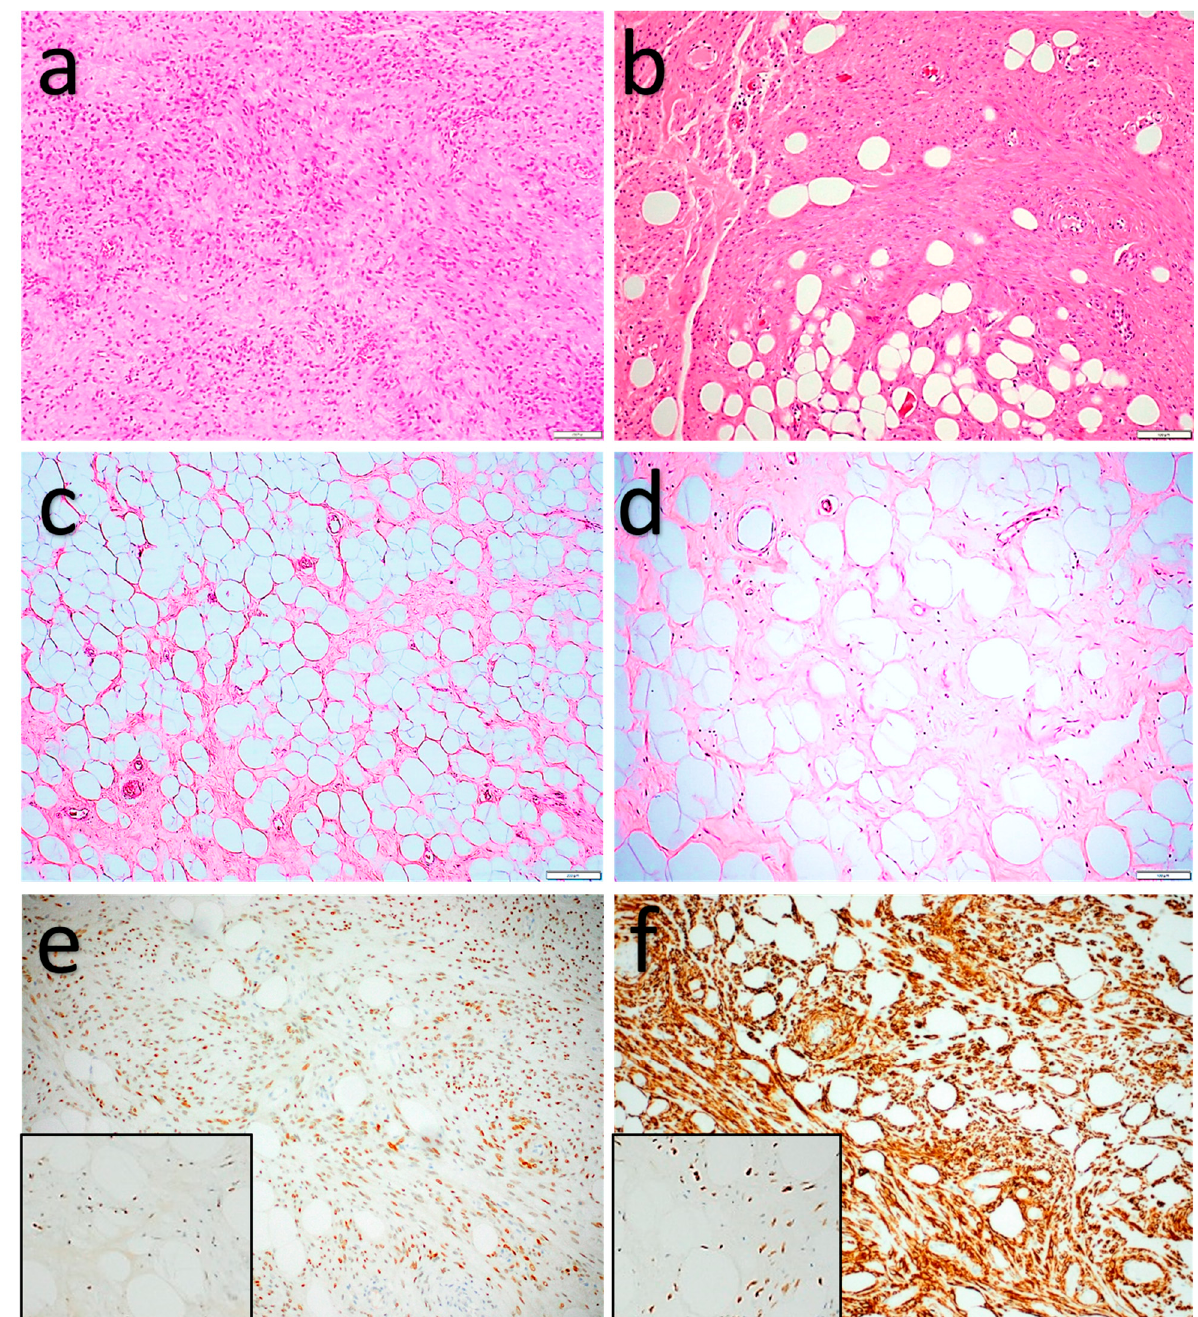
Figure 6. Myofibroblastoma. ( a ) Spindle cell tumor with fascicular growth showing short fascicles and collagenous background. ( b ) Bland spindle cells with eosinophilic cytoplasm and intermixed mature adipocytes. ( c ) Adipocytic-rich variant of myofibroblastoma with a dominant lipomatous component. ( d ) Adipocytic-rich variant: mature adipocytes and bland, haphazardly orientated spindle cells in a fibrous stroma. ( e ) Strong, diffuse nuclear progesterone expression. Inlet showing an adipocytic-rich variant. ( f ) Strong, diffuse cytoplasmatic desmin expression. Inlet showing an adipocytic-rich variant.